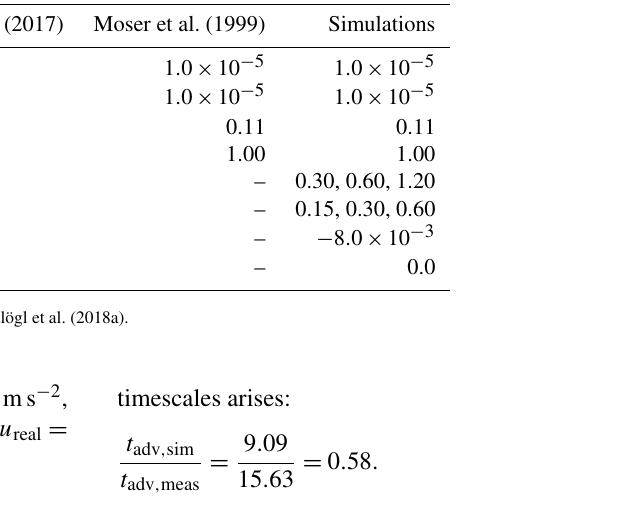
Table 2. Variable values applied in the simulations. Overview of the values used for obtaining the dimensionless parameters in the simula-